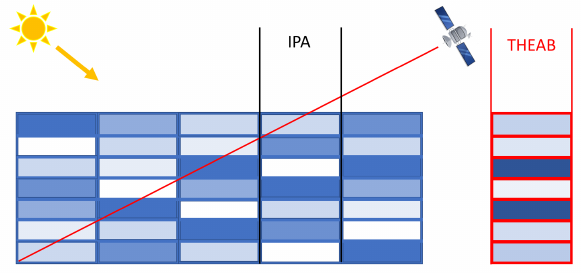
Figure 4. Schematic illustration of the tilted homogeneous extinc- tion approximation used to calculate the tilted homogeneous extinc- tion approximation bias (THEAB). The line of sight crosses vari- ous cloudy columns with variable extinctions, while the indepen- dent pixel approximation (IPA) considers only the cloudy column directly under the observed pixel at the top of the cloud. Note that each cell in the THEAB looks darker than in the IPA because we account for the longer path through the cell while keeping the cell size constant, which implicitly increases the